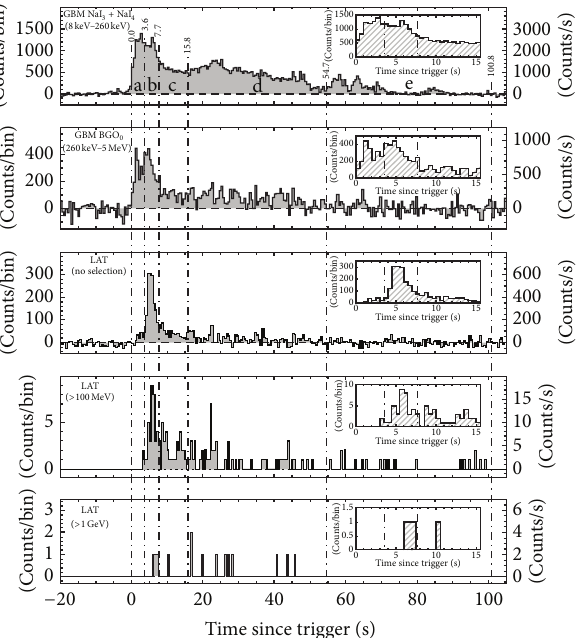
Figure 3: Light curves for GRB 080916C observed with the GBM and the LAT detectors on board the Fermi satellite, from lowest to highest energies. The top graph shows the sum of the counts, in the 8 to 260 keV energy band, of two NaI detectors. The second is the correspondingplotforBGOdetector0,between260 keVand5 MeV. The third shows all LAT events passing the onboard event filter for gamma-rays. (Insets) Views of the first 15s from the trigger time. In all cases, the bin width is 0.5 s; the per-second counting rate is reported on the right for convenience. Taken from Abdo et al.